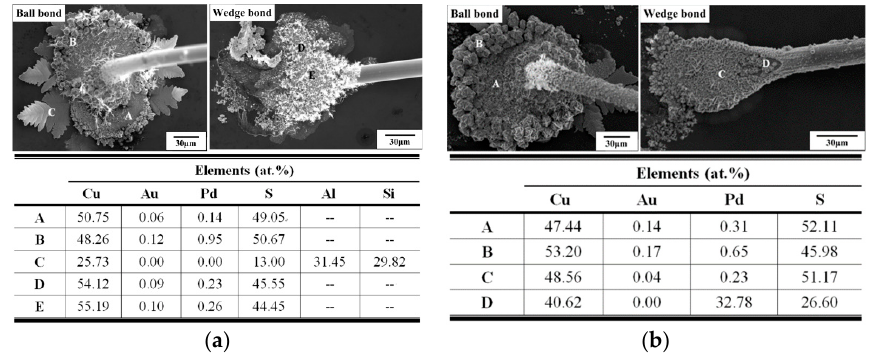
Figure 4. Morphologies of PCA wire bonding after different sulfidation durations: ( a ) 20 min and ( b ) 4 h.